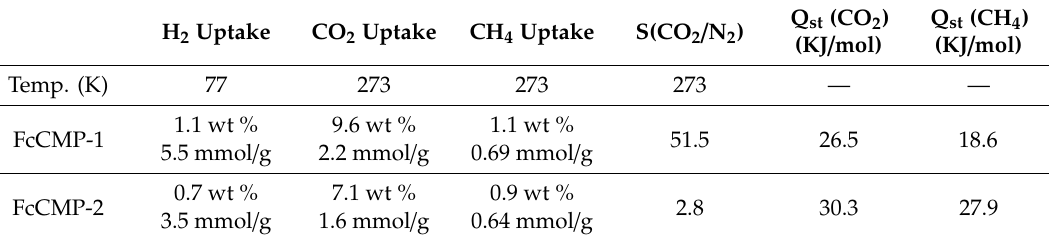
Figure 6. The CO 2 and CH 4 isosteric adsorption curve of FcCMPs. Table 2. Gas adsorption performance and isosteric heats of